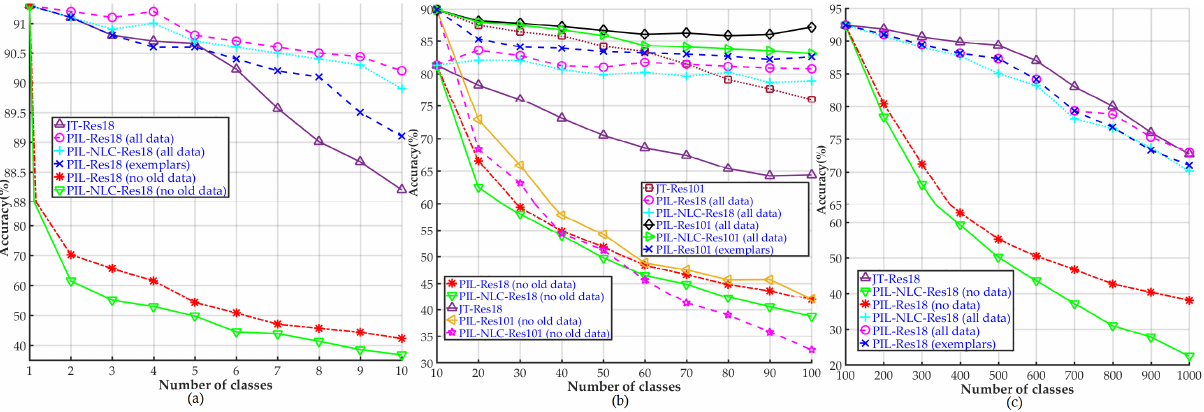
Figure 2. Performance comparison between joint training (JT), PIL-NLC and proposed PIL using two base networks (Res18 and Res101). Performance on ( a ) Fashion MNIST, ( b ) CIFAR-100 and ( c ) ImageNet-1000. In all the settings, the proposed PIL scheme achieve better results than PIL-NLC